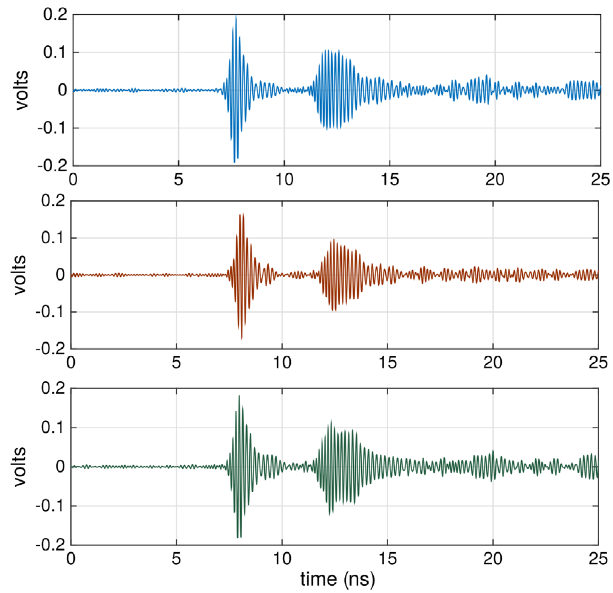
FIG. 8. ACE data using high-beam current runs, with ∼ 10 8 electrons per bunch. No amplifiers or preshower tungsten blocks were used in this configuration. Top: ACE1; middle: ACE2; bottom: ACE3. Both the primary pulse and the reflection from the shorted waveguide end are evident; the reflected signal is broadened due to waveguide